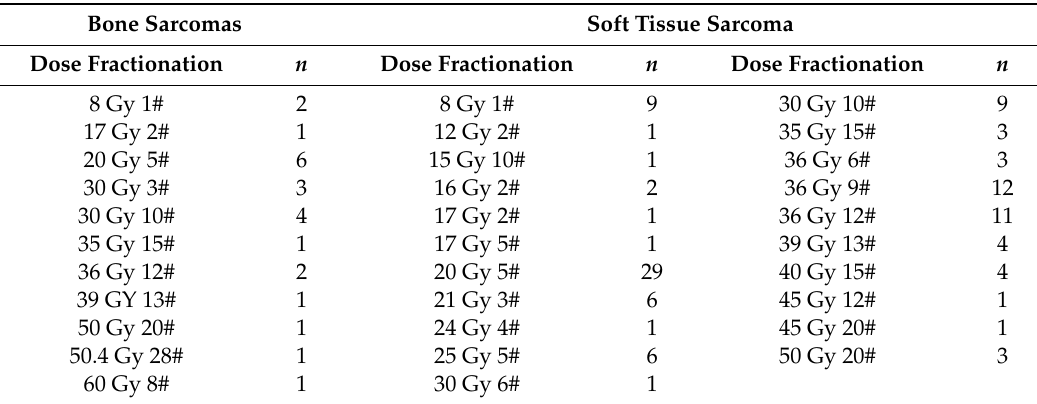
Table 2. Dose and fractionation schedules